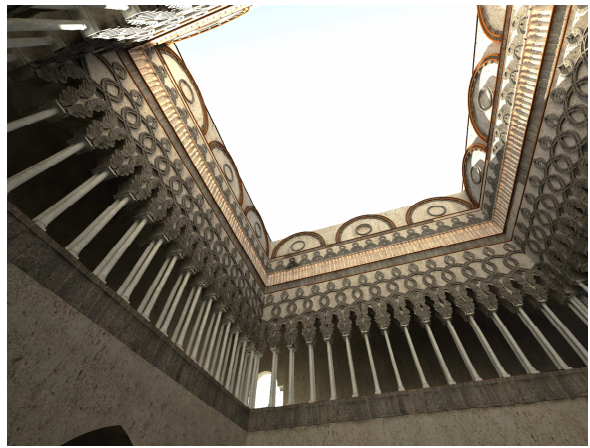
Figure 10. Rendering of the virtual model reconstruction same modules as the opposite of the ambulatory and replicating the sequence of coupled columns and arches overlying intertwined. In the virtual reconstruction, of course, for all ambulatory was adopted the same type of roofing vaults. For the lower level, virtually obliterating the walls nineteenth